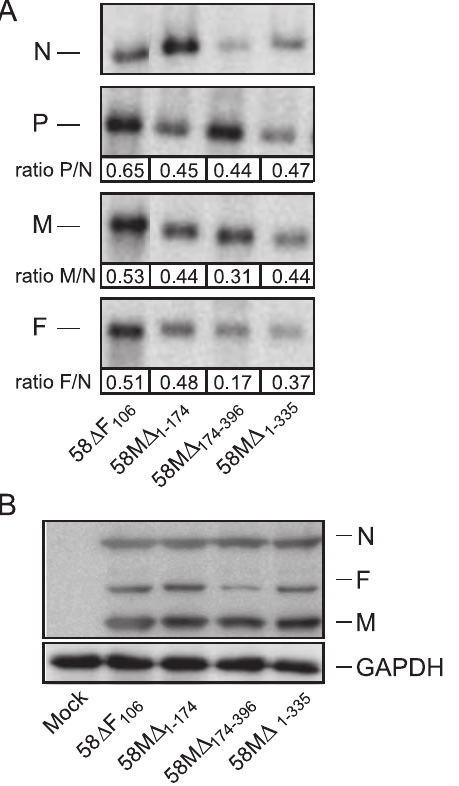
Figure 4. Effects of the M 3 9 UTR on transcription and trans- lation. ( A ) Northern blot analysis of viral mRNA with DNA probes. VerodogSLAMtag infected with the parental and recombinant viruses at an MOI of 1 were subjected to Northern blot analysis using DIG-labeled probes. Membranes were hybridized with DIG-labeled DNA probes for CDV N, P, M or F. Band intensities were determined by densitometry on non-saturated exposures using the Kodak Molecular Imaging software. The P, M and F expression were normalized by calculating the P/N, M/N and F/N ratios for each virus. The average mRNA ratios are shown beneath the appropriate bands and were calculated from at least four individual experiments. ( B ) Western blot analysis of viral N, M and F proteins. VerodogSLAMtag cells were infected with the parental and recombinant viruses at an MOI of 1 and overlaid with 0.5% methylcellulose. Cell lysates were extracted after 18 h and subjected to Western blot analysis. The membranes were probed with antibodies specific to the CDV N, M and F proteins. Intensities of N, M and F protein bands were determined by densitometry from non-saturated exposures using the Kodak Molecular Imaging Software. The M and F expression were normalized by calculating the M/N and F/N ratios for each virus and were calculated from at least four individual